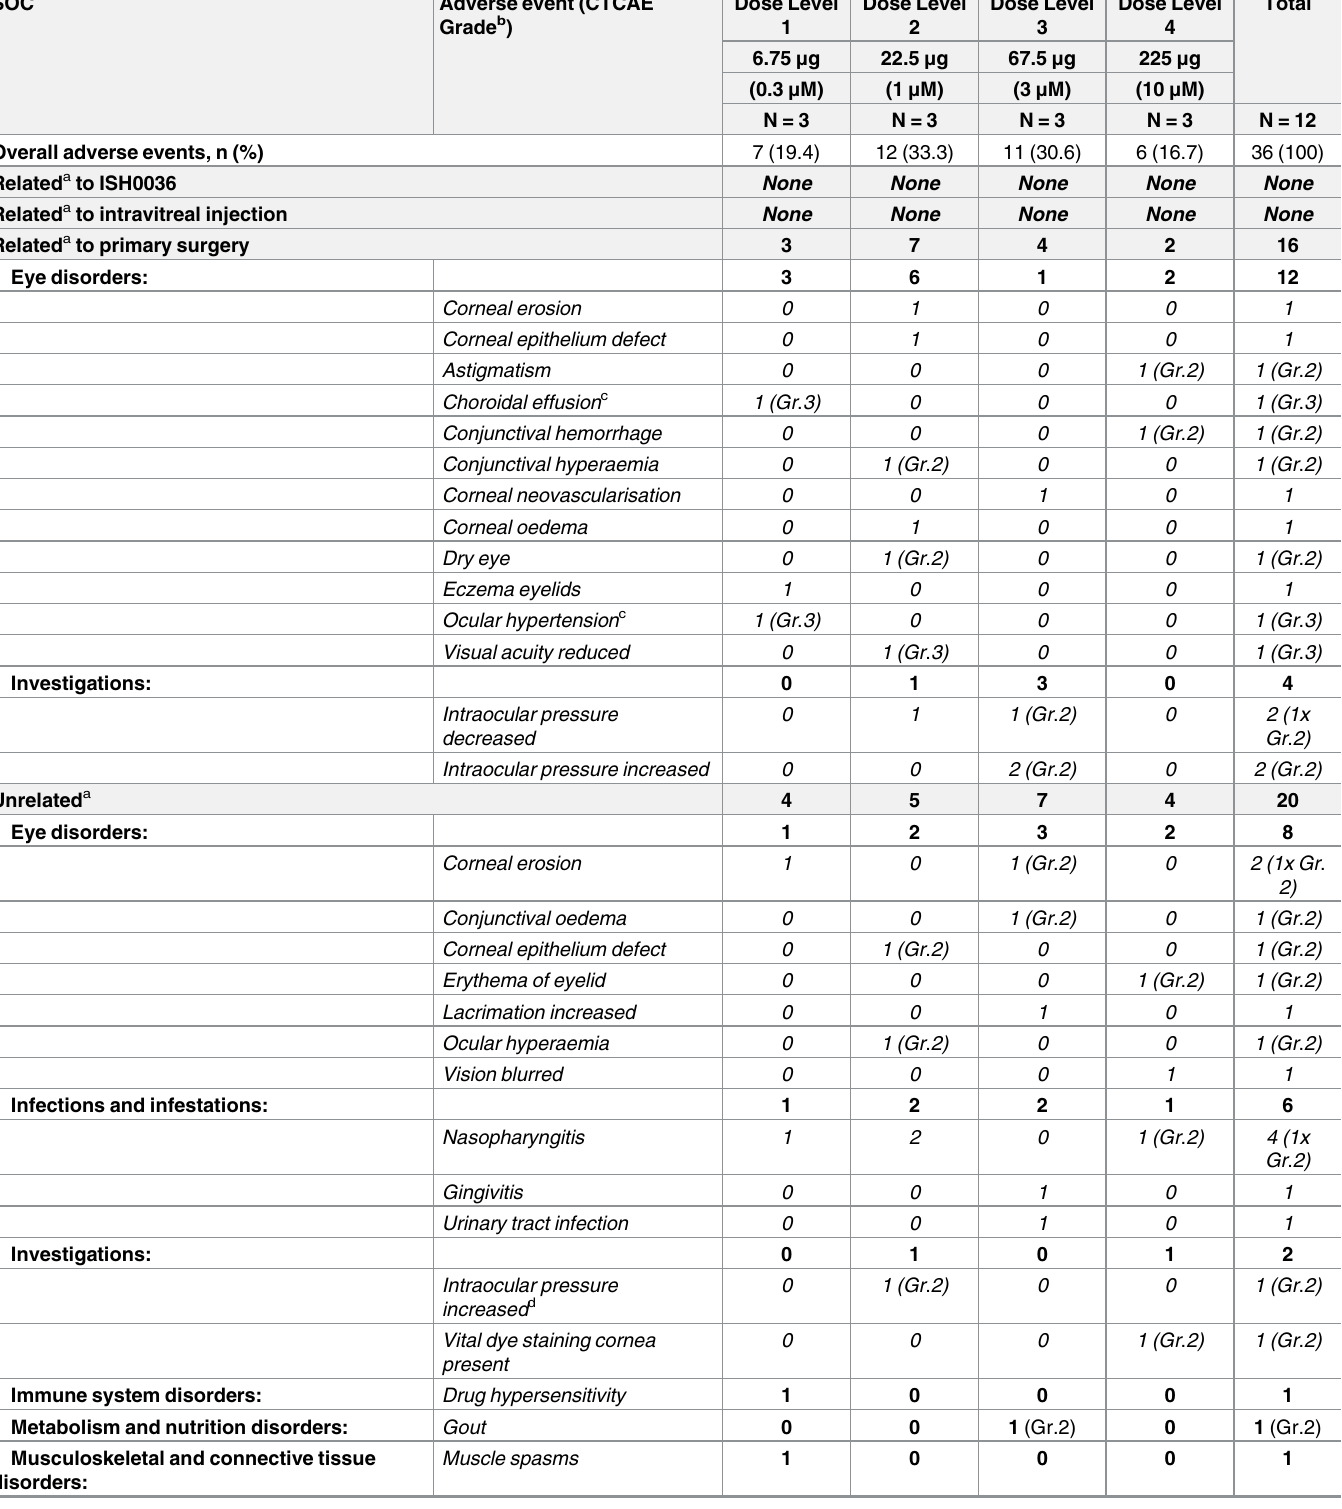
Table 3. Adverseevents by relationship, type and